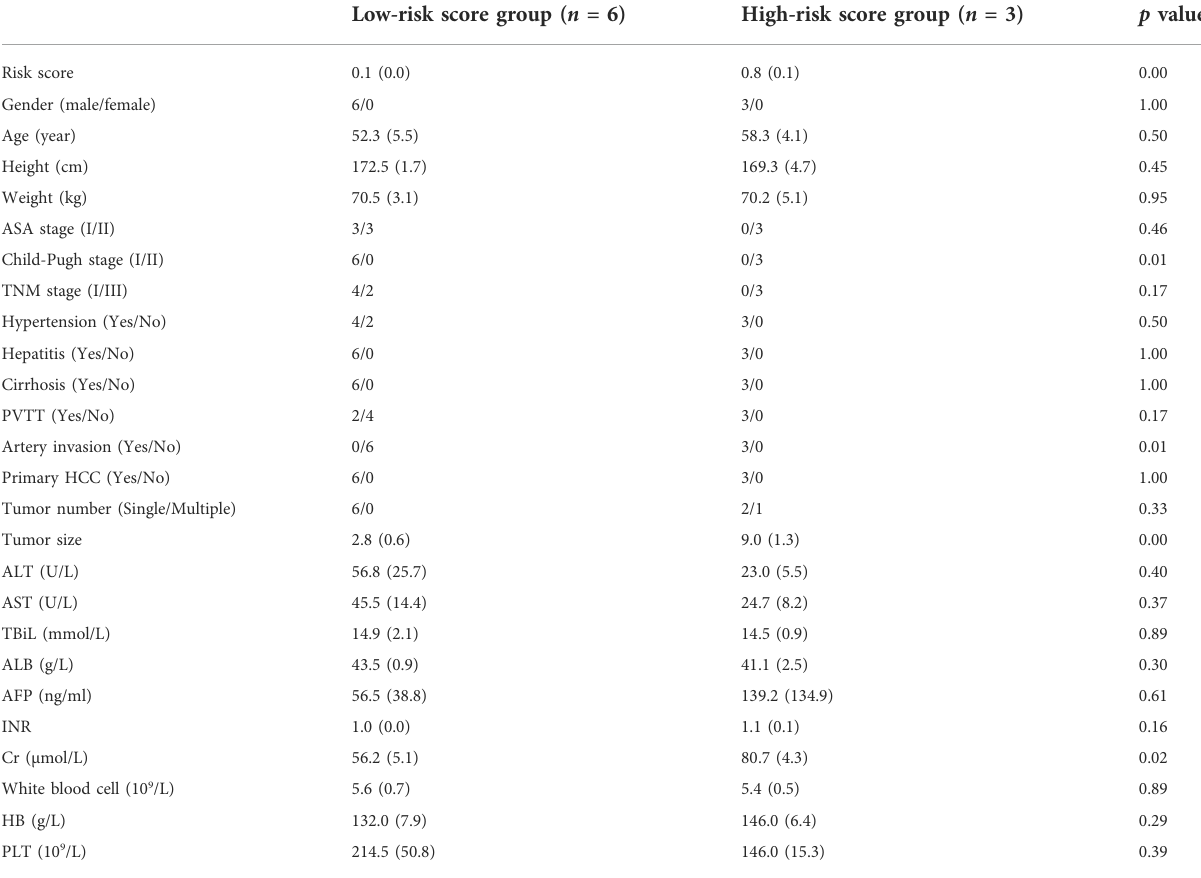
TABLE 1 Clinical characteristics of HCC patients between two groups divided by risk